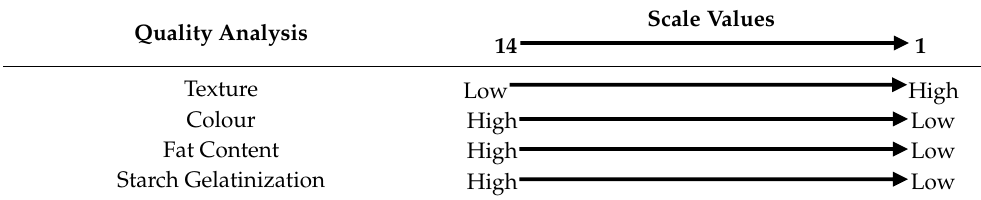
Table 1. Scale values of hierarchical scoring of rice noodle sample.